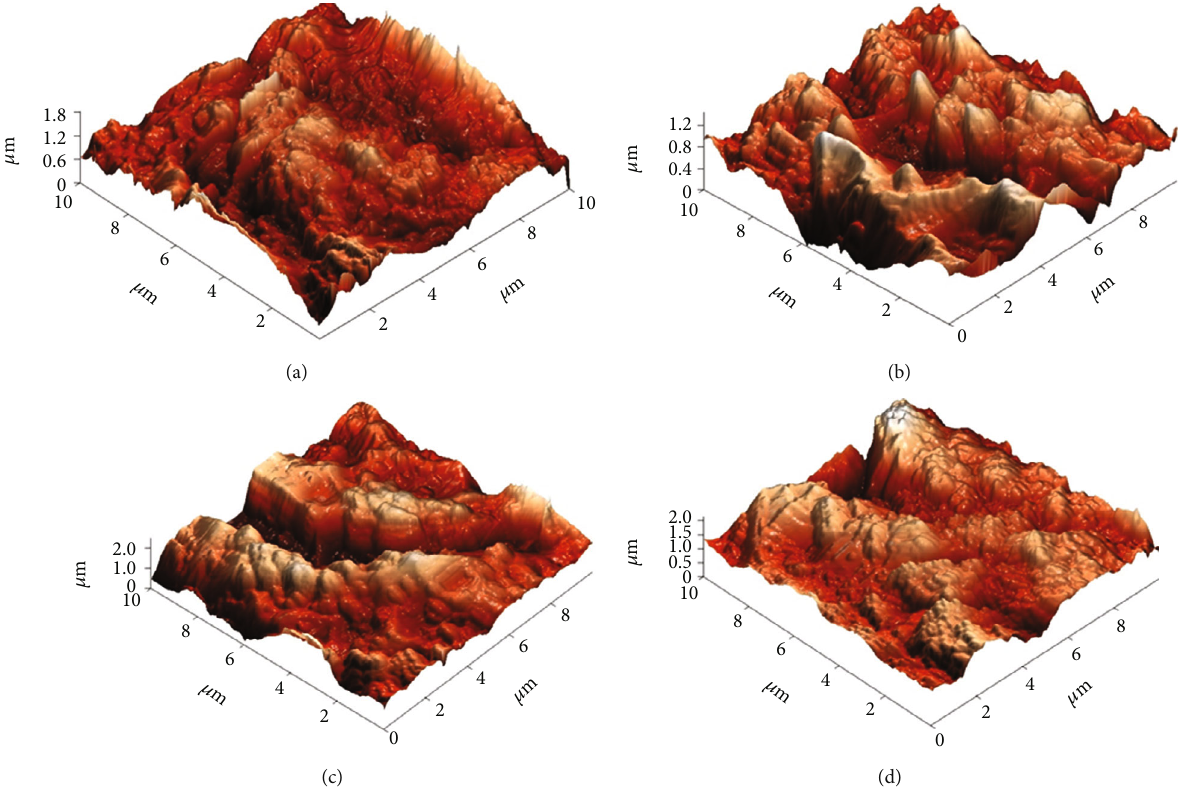
Figure 4: AFM results showing the topography of samples in 3D: (a) A-II, (b) A-III, (c) A-IV and (d) A-V.